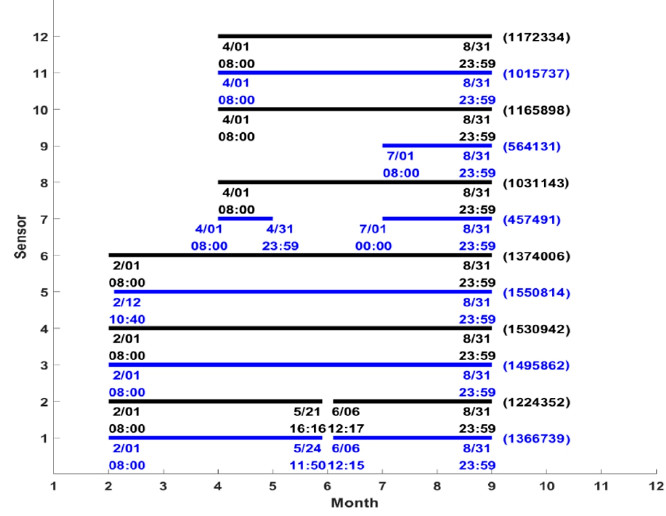
Figure 3. Twelve noise sensors collected data in different months.